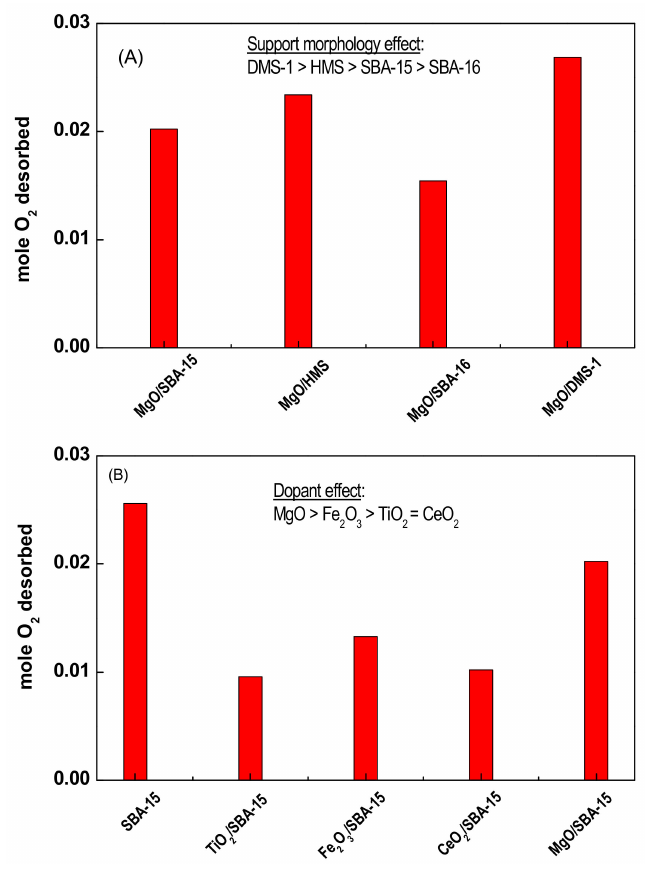
Figure 4. Oxygen storage capacity of the pure supports (from TPD-O 2 ): Effects of support structural properties ( A ) and SBA-15 substrate modification with different dopants ( B